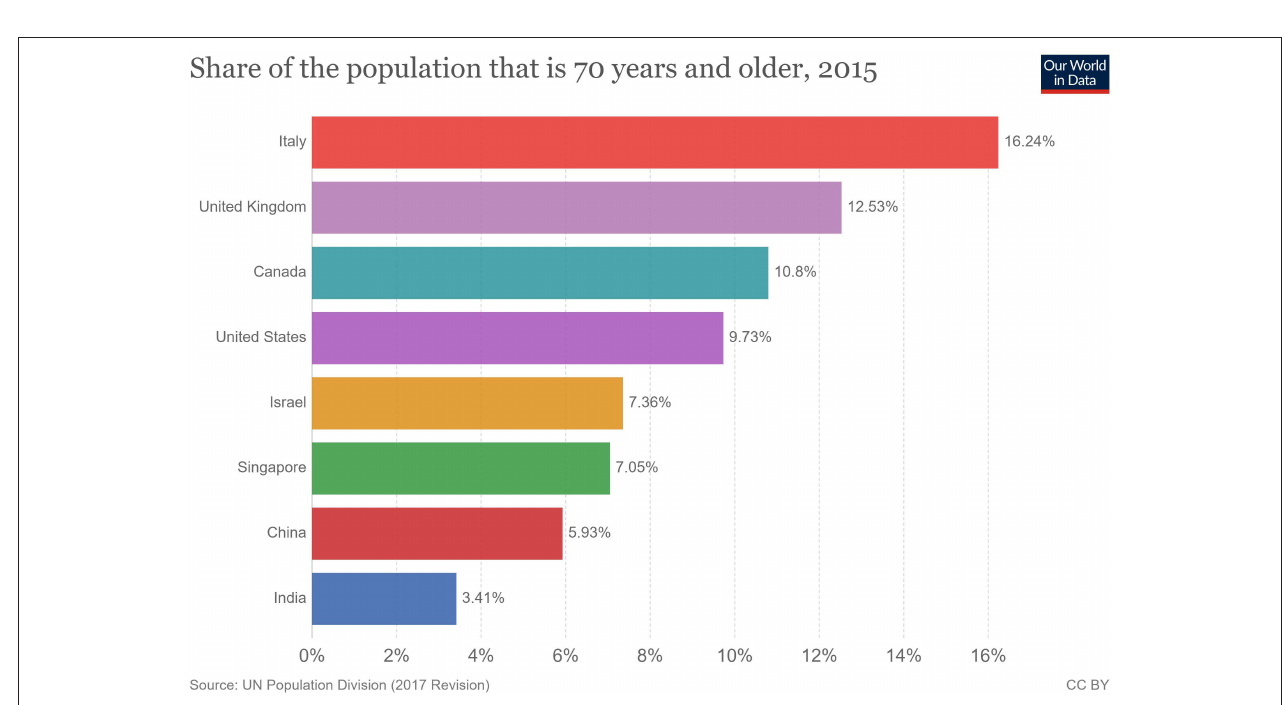
FIGURE 5 | Population share above 70 years of age (33).